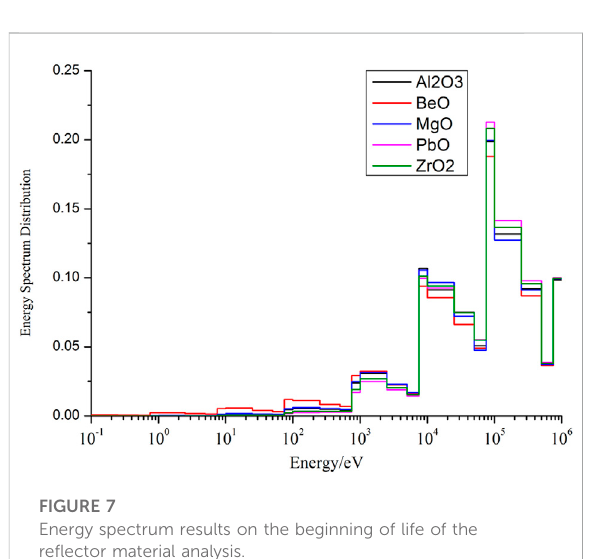
FIGURE 7 Energy spectrum results on the beginning of life of the re fl ector material